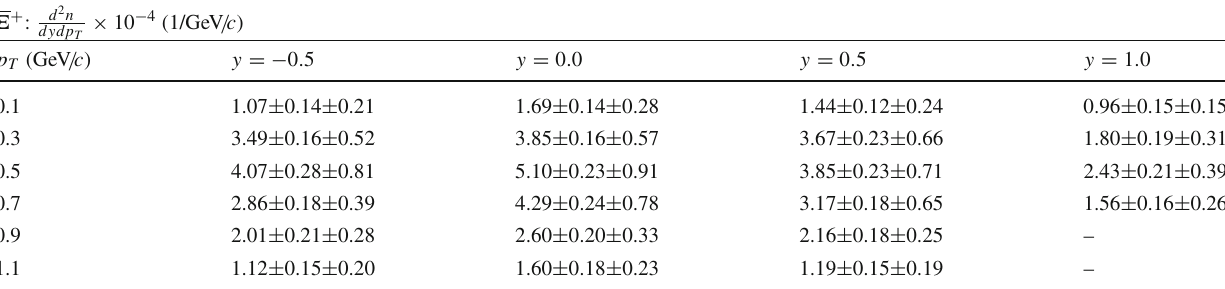
the presented bin. First value is the particle multiplicity, second repre- sents the statistical uncertainty and third one corresponds to the esti- mated systematic uncertainty